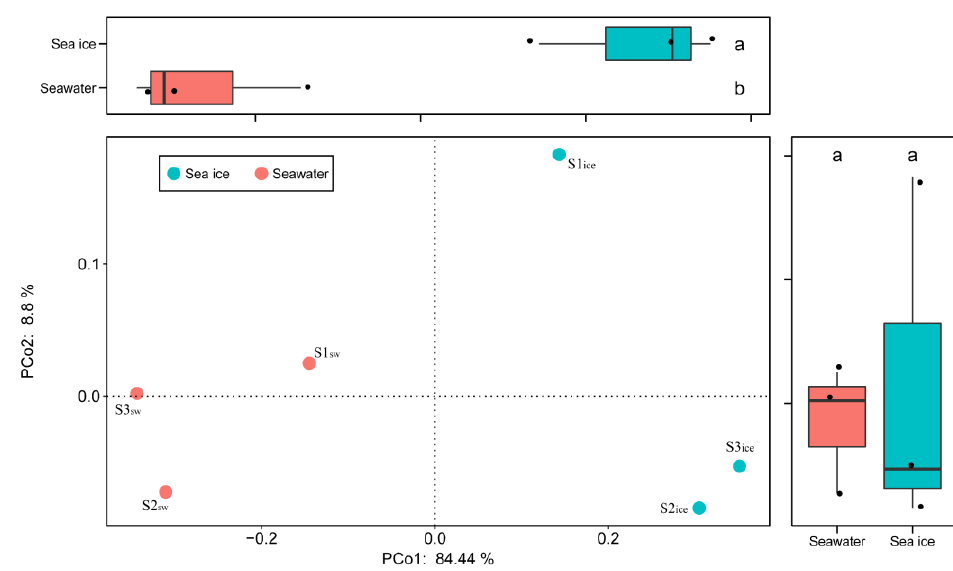
Figure 4. Principal coordinates analysis (PCoA) of Bray – Curtis distance for the eukaryotic micro-algal community in the seawater and in the sea ice. Different letters (a and b) denote significant differences ( p < 0.05).